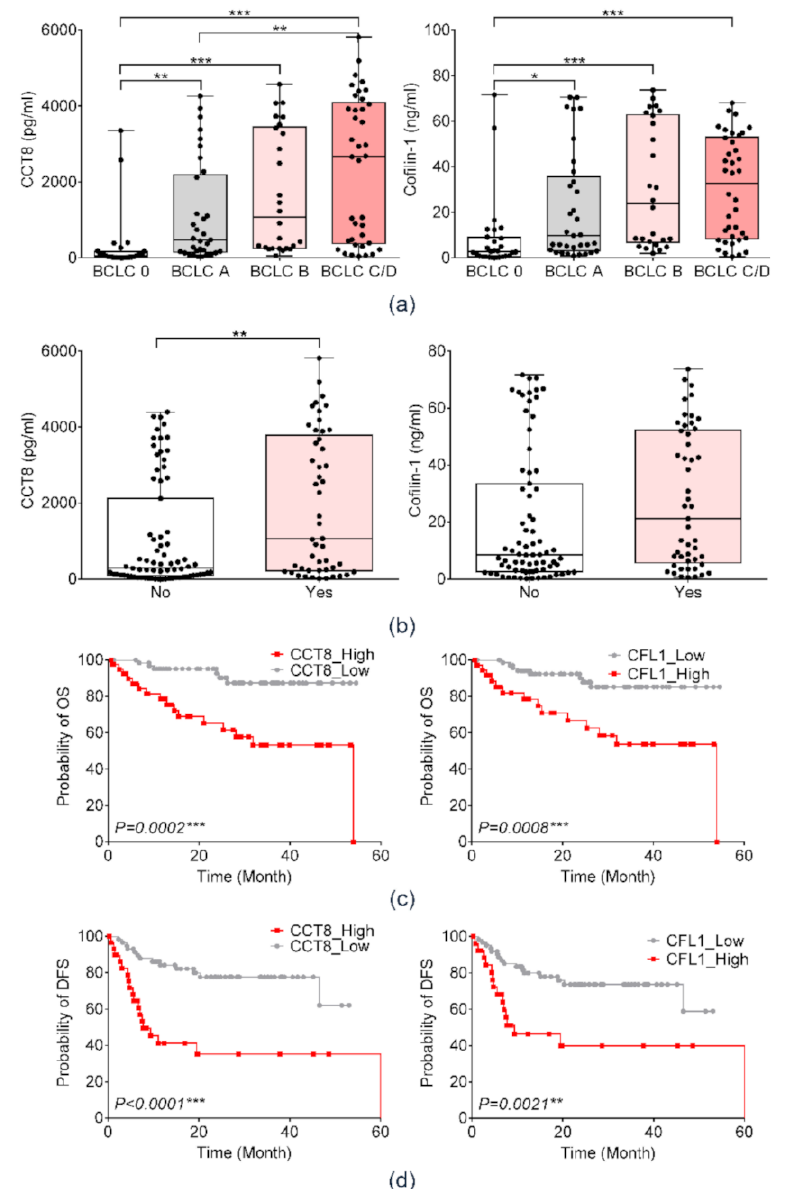
Figure 6. Prognostic significance of serum CCT8 and CFL1 in patients with HCC among the Ajou University Hospital liver disease cohort. ( a ) Expression of serum CCT8 and CFL1 according to BCLC stage guidelines. (Welch’s t -test; * p < 0.05, ** p < 0.01, *** p < 0.001) ( b ) Expression of serum CCT8 and CFL1 according to presence of vascular invasion. (Welch’s t -test; ** p < 0.01) ( c ) Overall survival according to expression of serum CCT8 and CFL1 in the validation cohort. ( d ) Disease-free survival according to expression of serum CCT8 and CFL1 in the validation